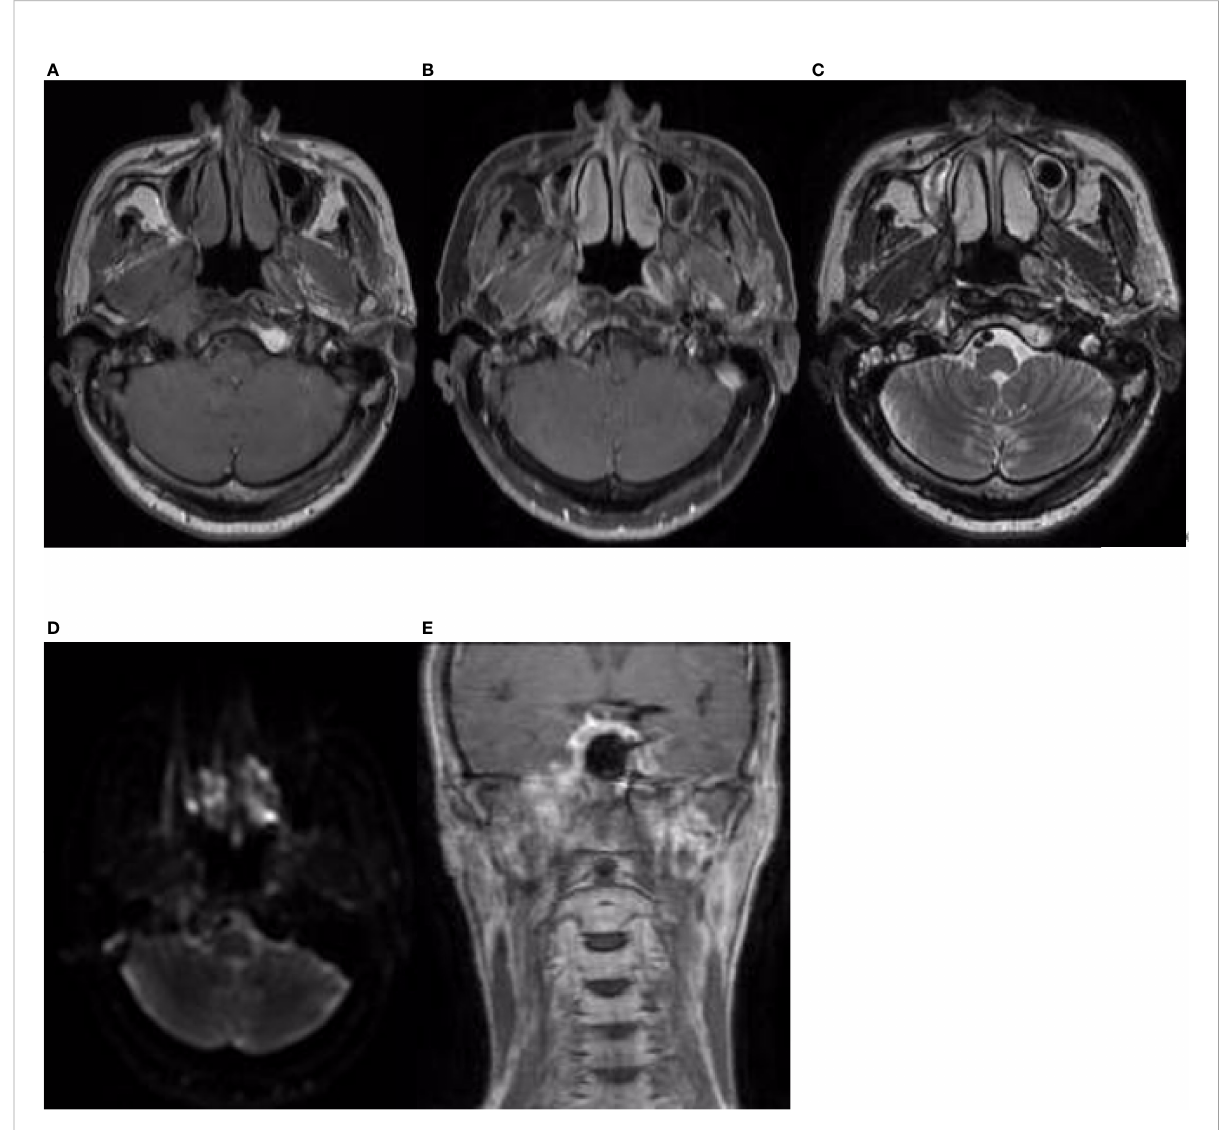
FIGURE 4 Nasopharynx and neck MRI fi ndings from 7 July 2020. (A – D) The axial planes of T1-weighted, enhanced T1-weighted, T2-weighted, and DWI and (E) the coronal plane of enhanced T1-weighted MRI, showing that the nasopharyngeal lesions and the necrotic area had subsided signi fi cantly. However, there was still a residual area of inhomogeneous enhancement in the right nasopharynx and parapharyngeal space, demonstrating restricted diffusion on